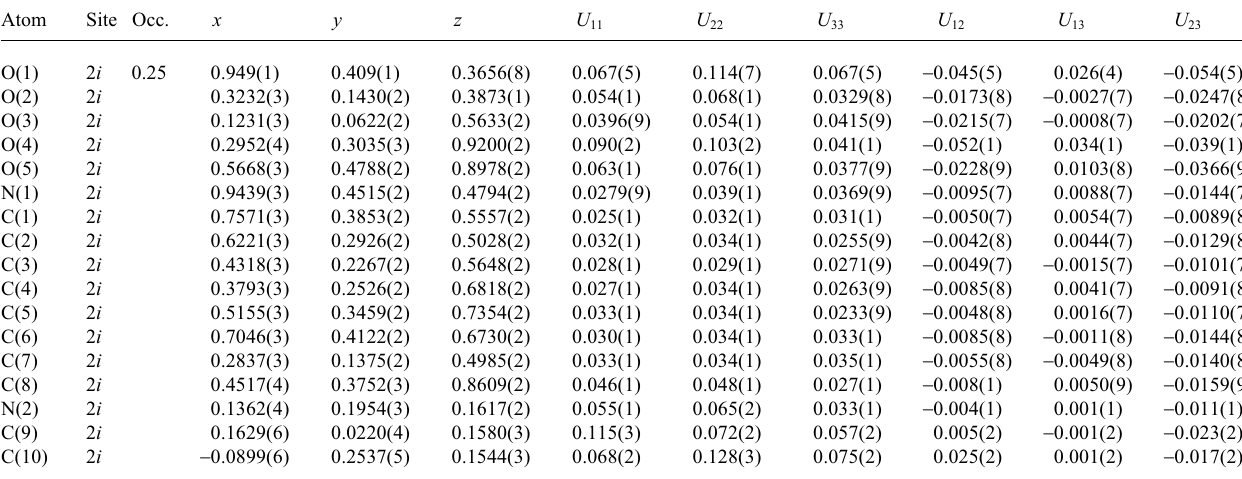
Table 3. Atomic coordinates and displacement parameters (in Å 2 ).